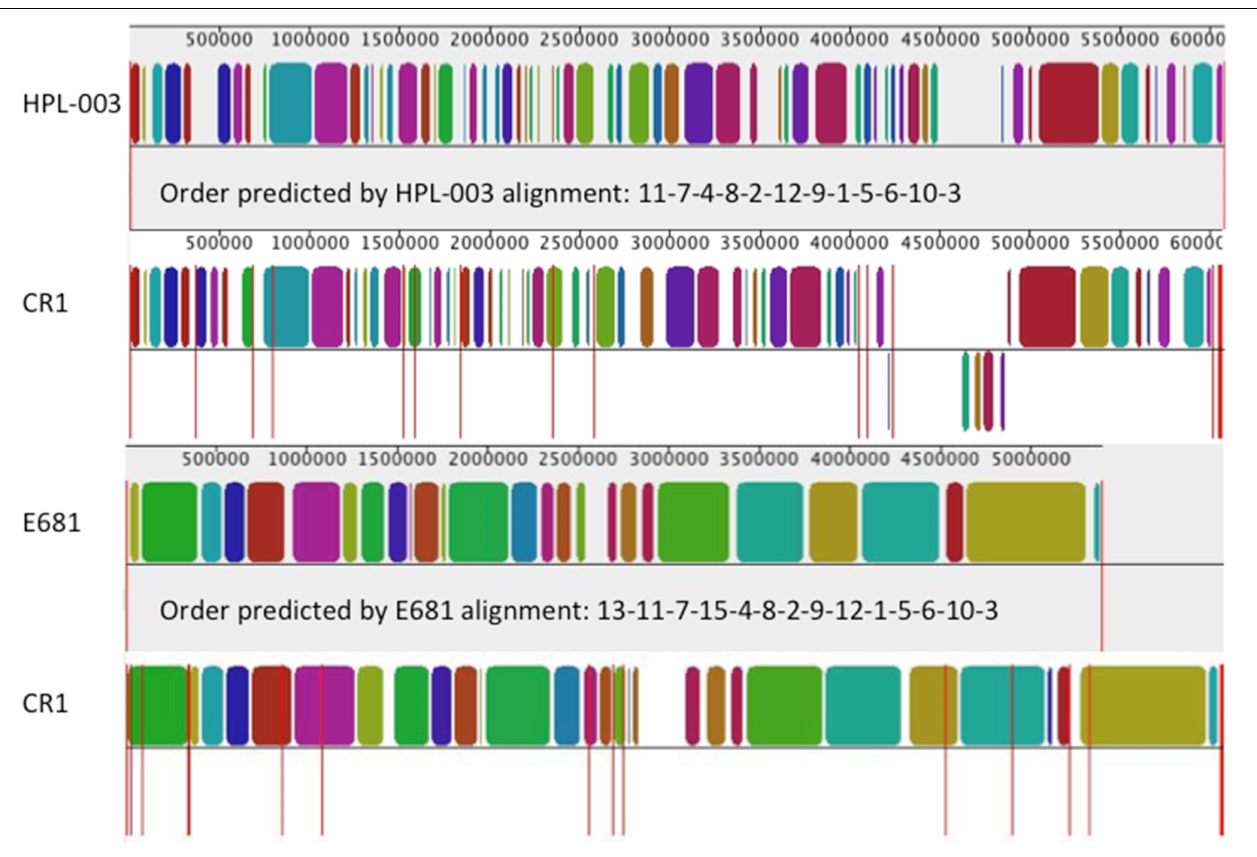
FIGURE 3 | CR1 draft genome scaffold assemblies with related reference genomes. The local collinear block (LCB) plot was generated with the contig reordering tool within Mauve using default parameters. The name of the strain represented is listed to the left of each LCB plot. HPL-003 represents Paenibacillus terrae strain HPL-003, a closely related species to P. polymyxa . Conversely, E681 represents P. polymyxa strain E681, the closest related P. polymyxa strain to CR1. The contigs